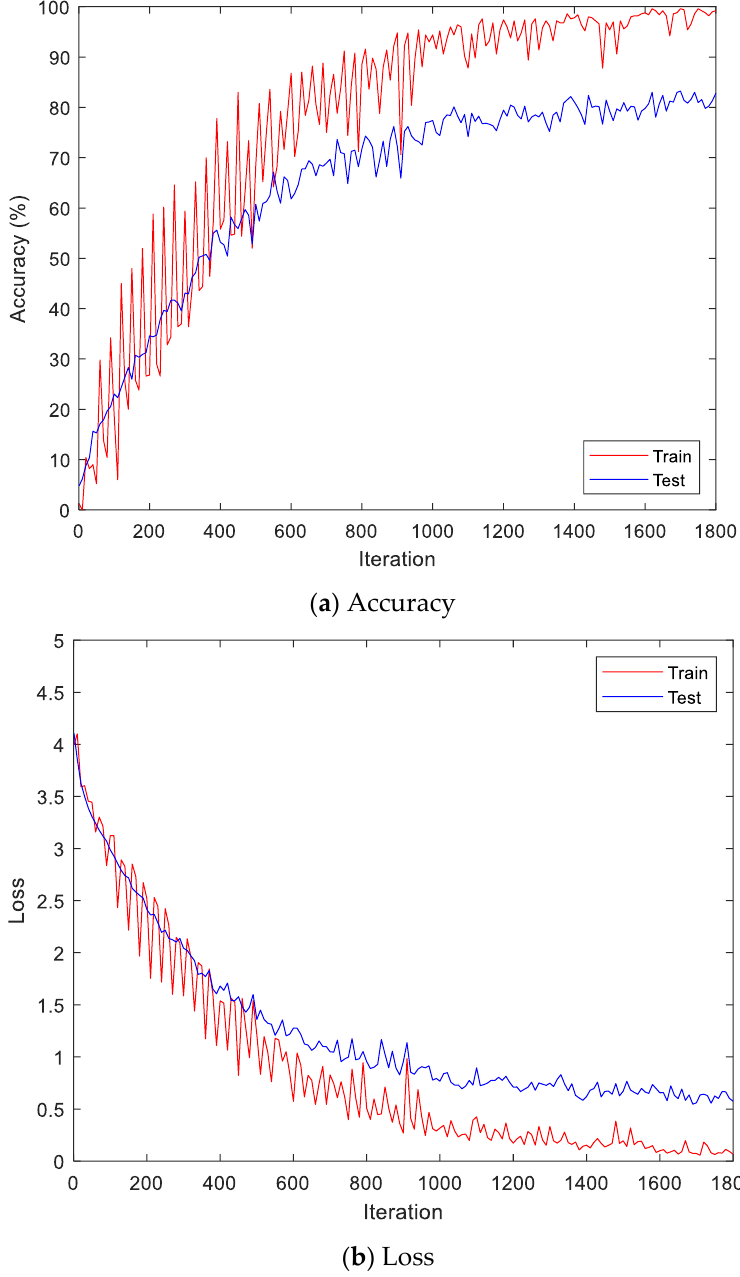
Figure 10. Training process by the feature extraction and LSTM-based individual identification model (Angeles EMG dataset).